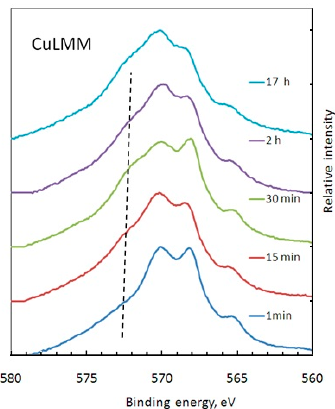
Figure 6. Evolution of the Auger CuLMM spectrum, depending on exposure time of the brass sample in 0.01 mM MPATA solution (broken line presents position of CuMPATA complex).